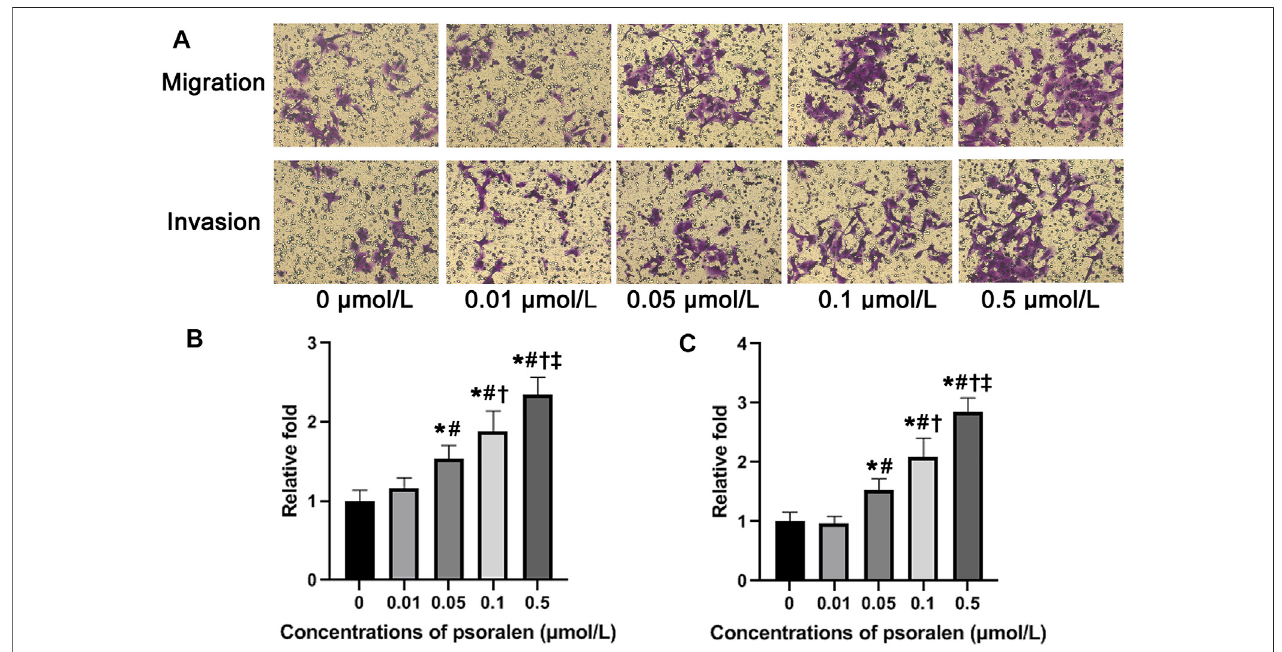
FIGURE 2 | Psoralen strengthens migration and invasion ability of HTR-8/SVneo cells. (A) Representative images of Transwell assay of HTR-8/SVneo cells after exposure todifferent concentrations (0, 0.01, 0.05, 0.1, and 0.5 μ mol/L) of psoralen for 24 h. (B) Changes in the number of migrating cells in relation to control cells. (C) Changes in the number of invading cells in relation to control cells. Values are mean ± SD. Experiments were performed in triplicate and repeated three times. * p < 0.05 vs. 0 μ mol/L; # p < 0.05 vs. 0.01 μ mol/L; † p < 0.05 vs. 0.05 μ mol/L; ‡ p < 0.05 vs. 0.1 μ